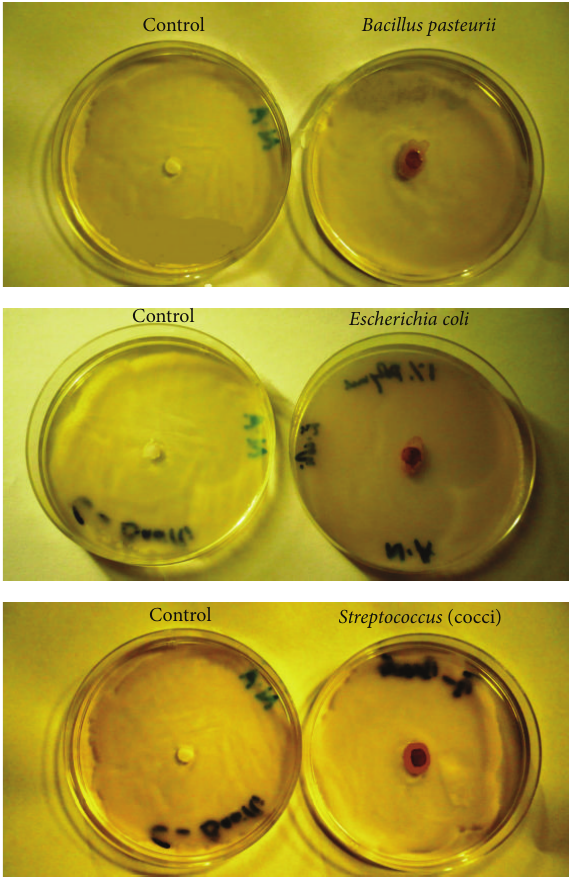
Figure 13: Antibacterial activity of HBPE-St85.